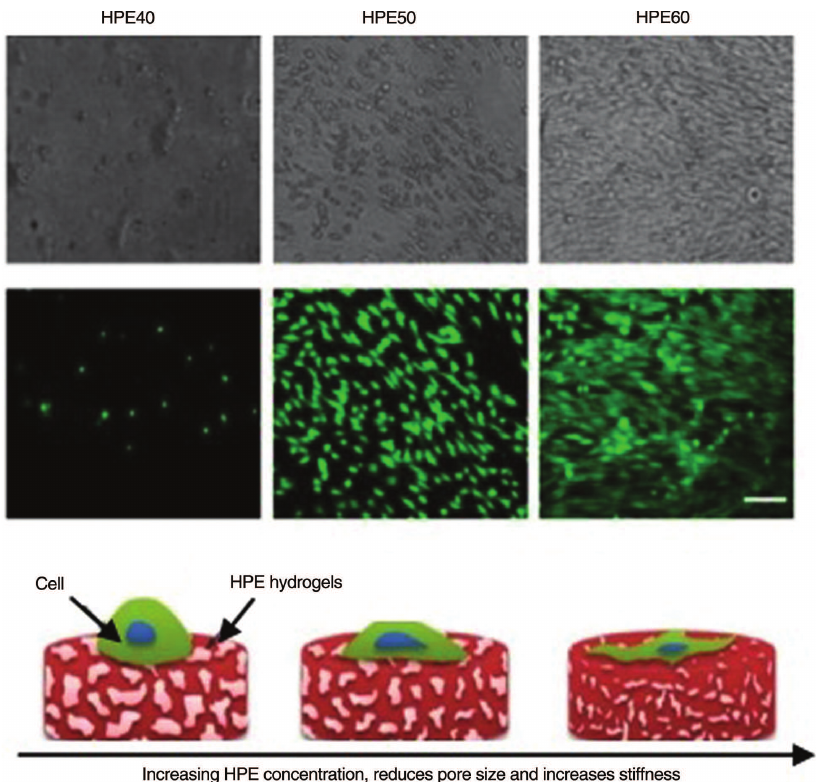
Figure 6: The representative phase contrast and fluorescent images of fibroblasts on the surface of the HPE hydrogels. Cells readily attached and spread on hydrogels with higher HPE concentration. Adapted with permission from Ref. [20]. Copyright (2013) American Chemical Society.